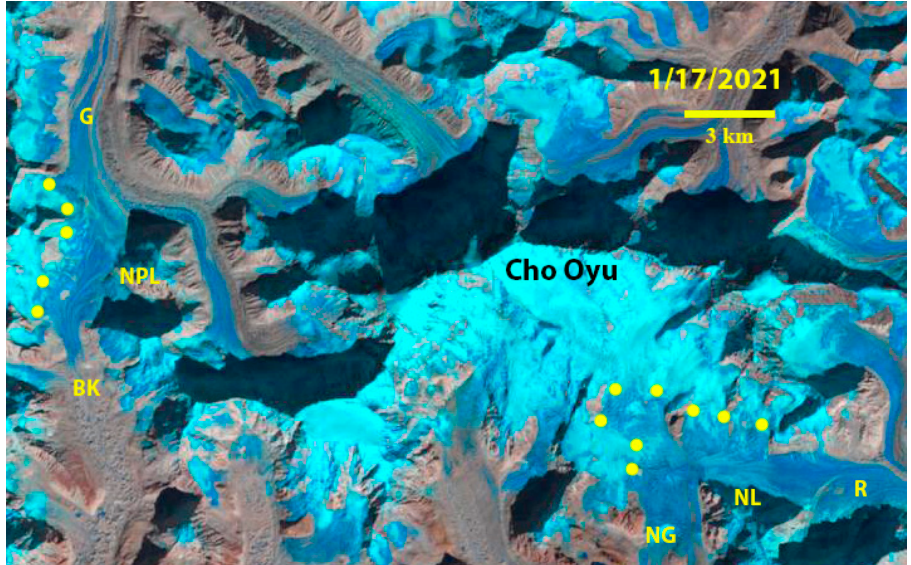
Figure 3. Glacier snow line on Mount Everest glaciers on 17 January 2021 as per a Landsat image. NG = Ngozumpa Glacier; NL = Nup La; R = Rongbuk West Glacier; NPL = Nangpa La; G = Gyabrag Glacier and BK = Bhote Koshi Glacier. Yellow dots mark locations of snow line elevation determination.